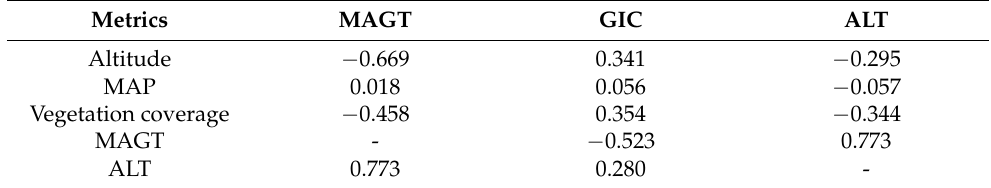
Table 4. Correlation coefficient matrix of environmental constraints with key permafrost metrics in the Gaize